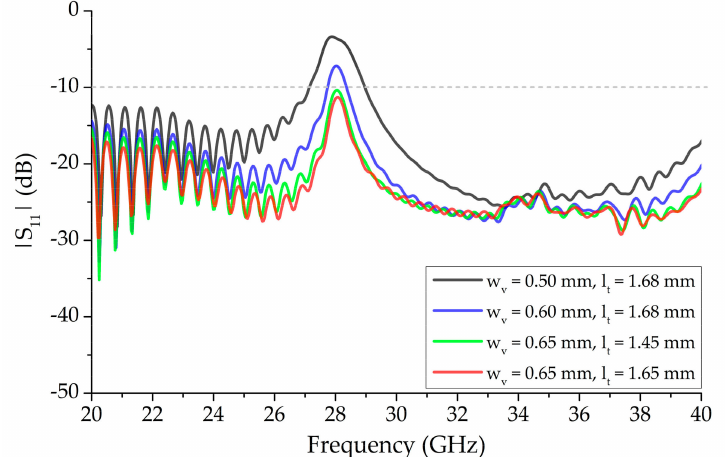
Figure 5. E ff ect of varying vertical bowtie segment parameters, w v and l t , of 13 unit-cell element periodic structure independently on | S 11 | while the other parameters remain the same as Table